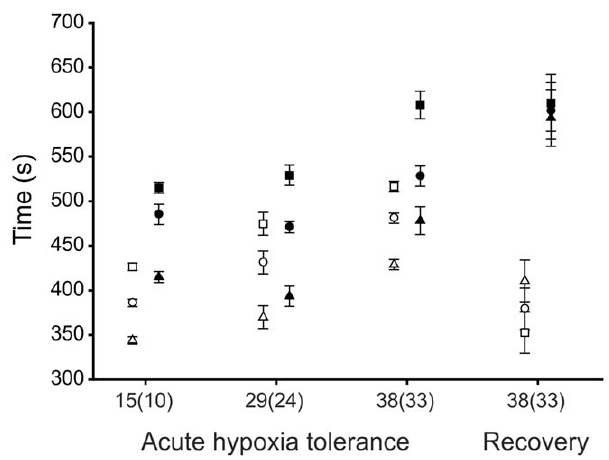
Figure 1. Variation among treatments in the tolerance of, and recovery from, acute hypoxia at various generations. Male (open symbols) and female (closed symbols) D. melanogaster were evolved under normoxic (circles), hypoxic (squares) or hyperoxic (triangles) conditions and tolerance was assayed after 15(10), 29(24) and 38(33) generations of experimental evolution, and recovery after 38(33) generations. Hyperoxia-exposed flies (generation numbers in parentheses) were started five generations after the other treatments. All flies were raised in a common normoxic environment for two generations prior to conducting the assay. Treatment means 6 SEM are displayed. Treatment effects on acute hypoxia tolerance are significant at every time point and the three treatments differ significantly from one another in post-hoc comparisons (p , 0.001 in all cases). Sexes do not differ at any time point (p . 0.15 in all cases). Recovery time differed between sexes (p=0.039) but not between treatments (p=0.849), although the sex 6 treatment interaction approached significance